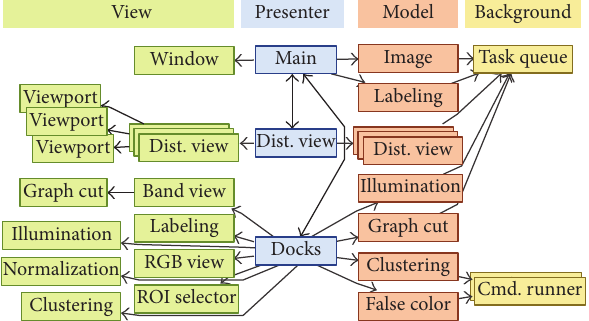
Figure 13: GUI software design. Presenter components control both view and model